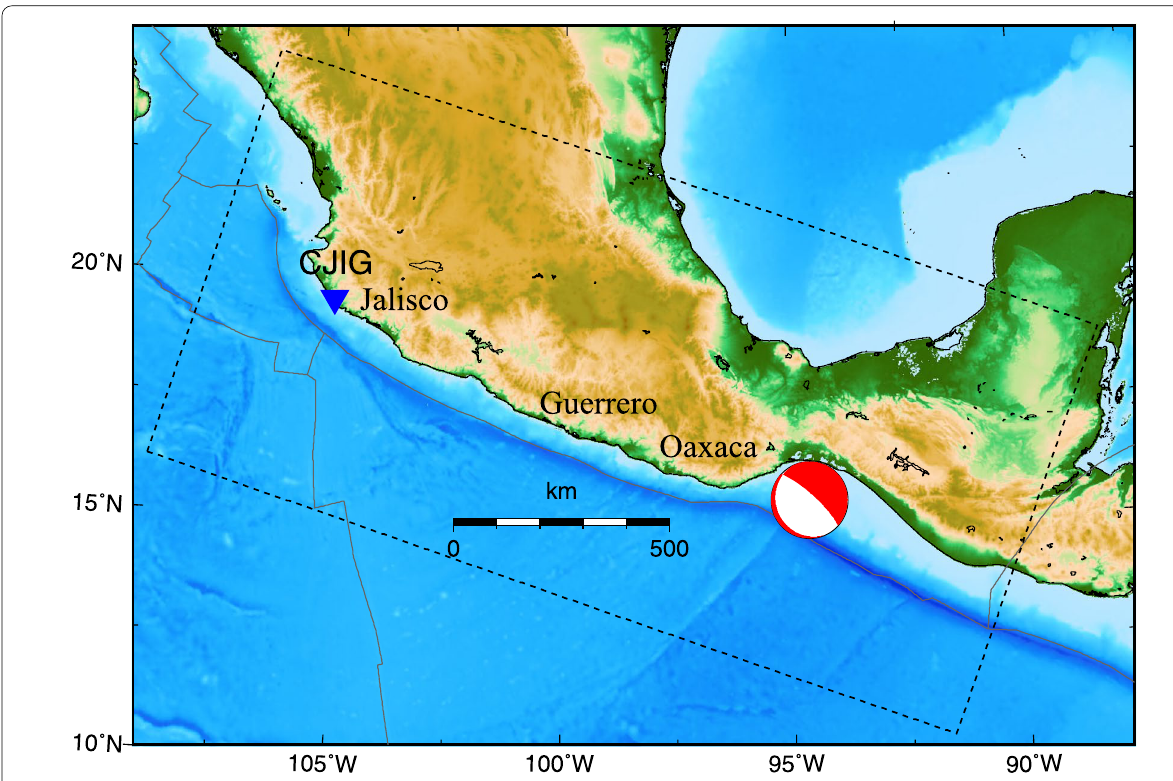
Fig. 1 Map showing the study region. The focal mechanism of the 2017 Tehuantepec earthquake from the global CMT catalog is indicated. An inverted triangle shows the position of the SSN station CJIG. Synthetic wavefields of the 2017 Tehuantepec earthquake are calculated in the region bounded by the dashed rectangle. Solid lines show plate boundaries (Bird